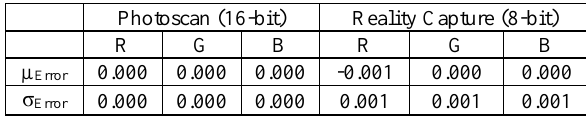
Table 3. 32-bit colour errors (measured in tones) of a colour chart measured as 16-bit images before and after processing the images in Agisoft Photoscan (2018) and Capturing Reality Capture (2018) as 32-bit